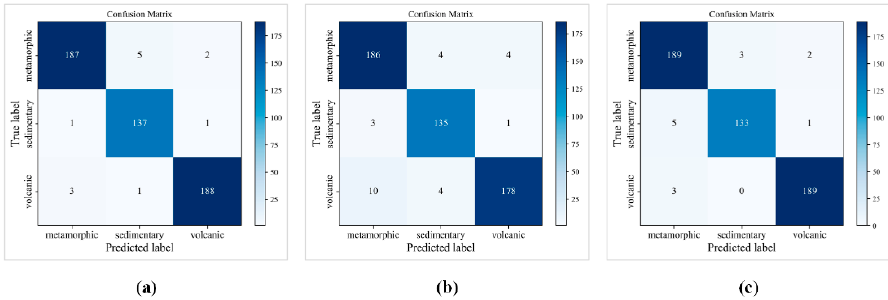
Figure 10. Confusion matrixes: ( a ) RMSprop optimizer; ( b ) SGD optimizer; ( c ) Adam optimizer.